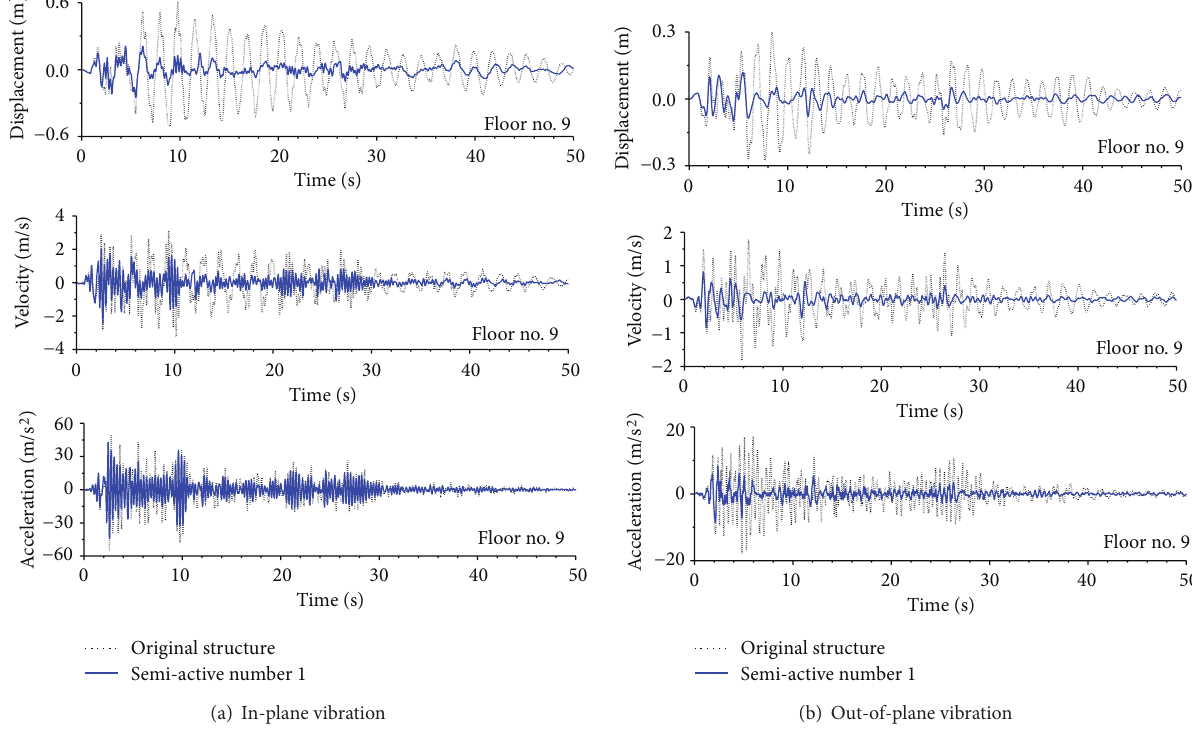
Figure 18: Control performance on top of the transmission